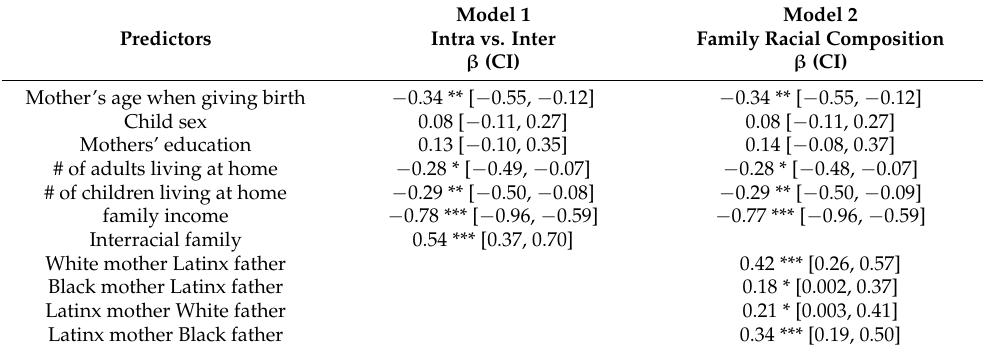
Table 3. Negative binomial models for predicting overall ACEs score.